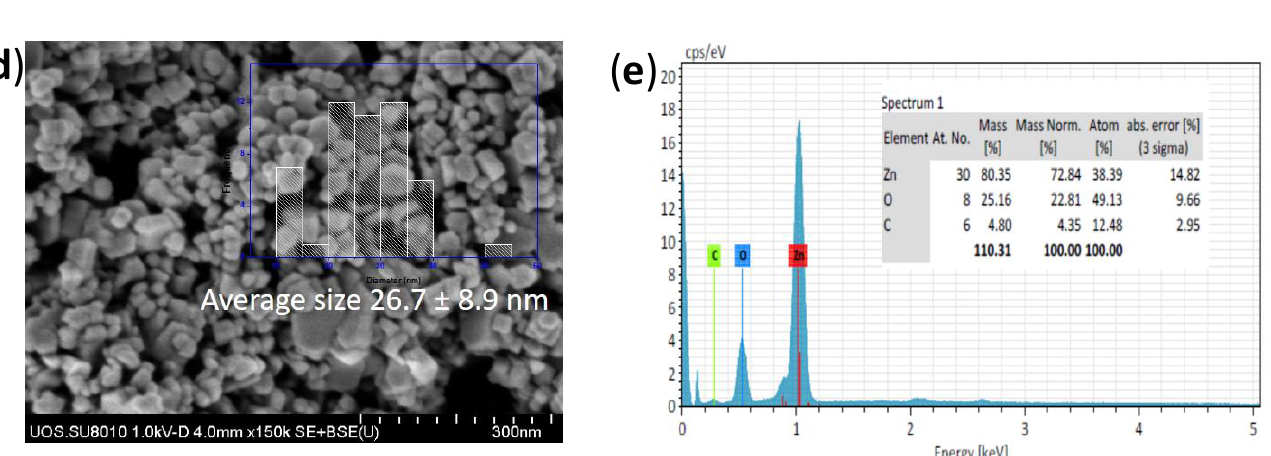
Figure 1. ( a ) UV-vis spectra, ( b ) XRD pattern, ( c ) FTIR spectra, and ( d , e ) FESEM and EDX of ZnONPs. For further characterization of the ZnONPs, the hydrodynamic particle size (Z avg ) and polydispersity index (PDI) were analyzed using dynamic light scattering. The Z avg and